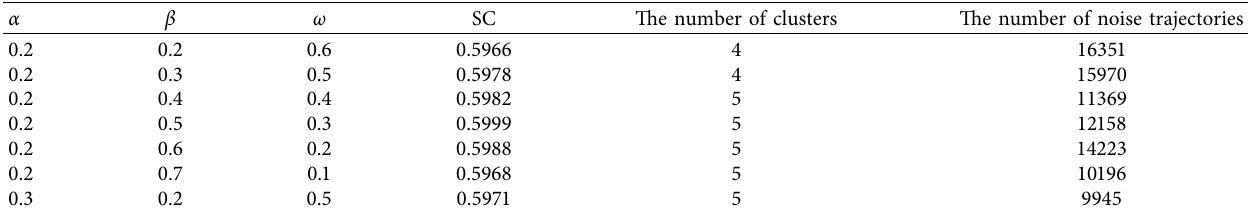
Figure 5: Parameter configuration for the data collected on weekend: (a) the SC under different combinations of weight coefficients and and MinTRs . (b) the curve used to determine MinTRs min max Table 1: Comparison of different parameter combinations for workday